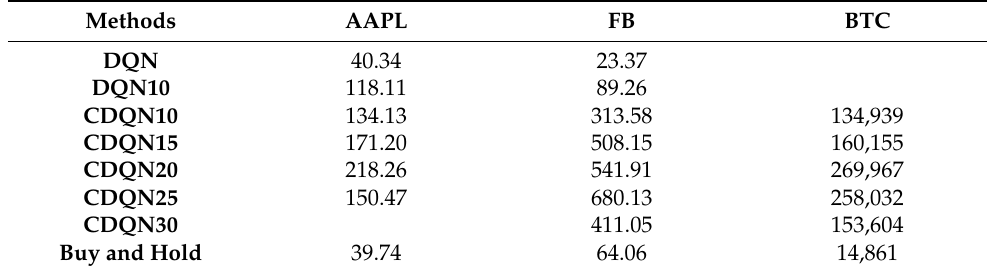
Figure 5. Different trading strategies for BTC (Bitcoin). ( a ) The left figure shows the cumulative wealth curves in 2021 using different trading strategies including CDQNn ( n ∈ { 5,10,15,20,25,30 } ) and Buy and Hold. ( b ) The right figure shows the Sharpe ratio curves in 2021 using CDQNn ( n ∈ { 5,10,15,20,25,30 } ) and Buy and Hold. Table 1. Cumulative Wealth for Different